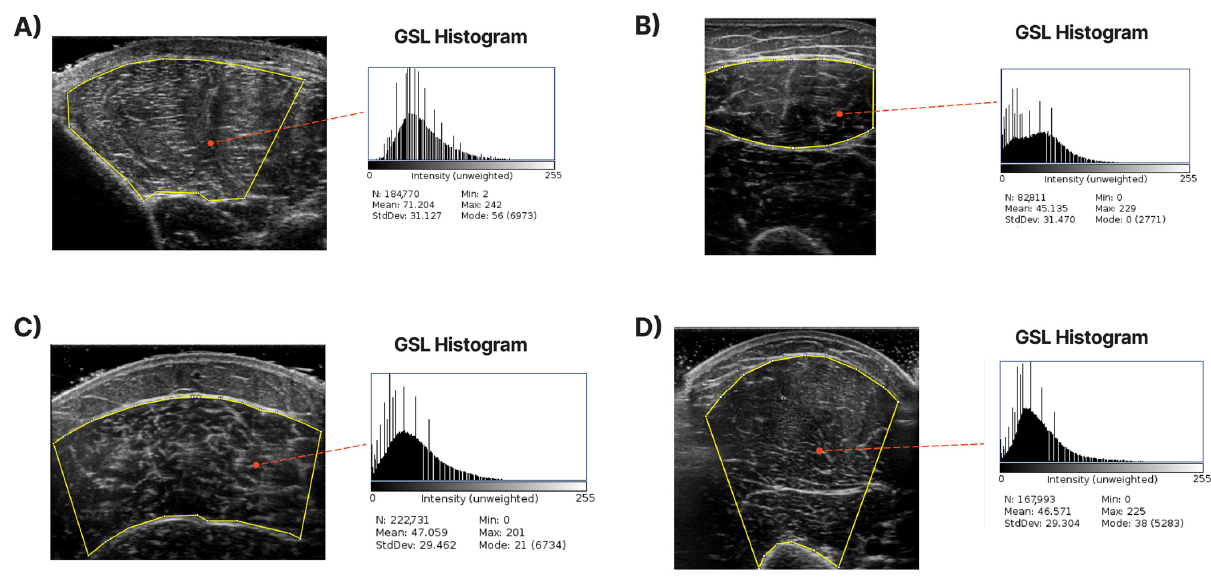
Figure 2. Sample of ultrasound images with their corresponding annotation. The CSA area contours are depicted with yellow lines. The grayscale level (GSL) histogram and its mean value are extracted inside the CSA. ( A ) shows the measurements of T.A., ( B ) shows the measurements of R.F., ( C ) shows the measurements of the GCM, and ( D ) demonstrates B.B.